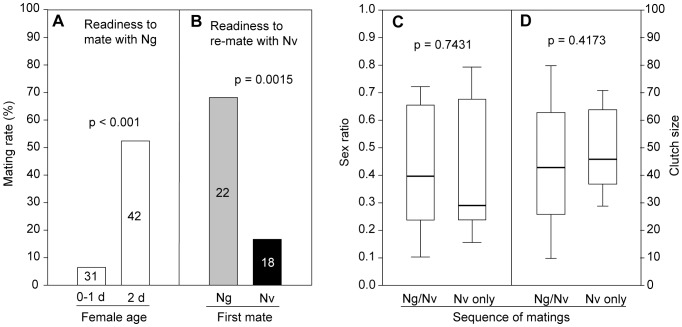
Mating and re-mating behaviour of Nasonia vitripennis females and resulting offspring.(A) Proportion of Nasonia vitripennis (Nv) females of different age that mated with N. giraulti (Ng) males in the mating trials and (B) proportion of 2-d-old Nv females that re-mated with an Nv male after a first mating with either an Ng or an Nv male. Digits on the columns represent numbers of replicates in the individual experiments (data analysis with a 2×2 X2-test). (C) Offspring sex ratios and (D) clutch size produced by Nv females after sequential double mating with an Ng and an Nv male (Ng/Nv) or after mating with an Nv male only (data analysis with a Mann-Whitney U-test, n = 20).